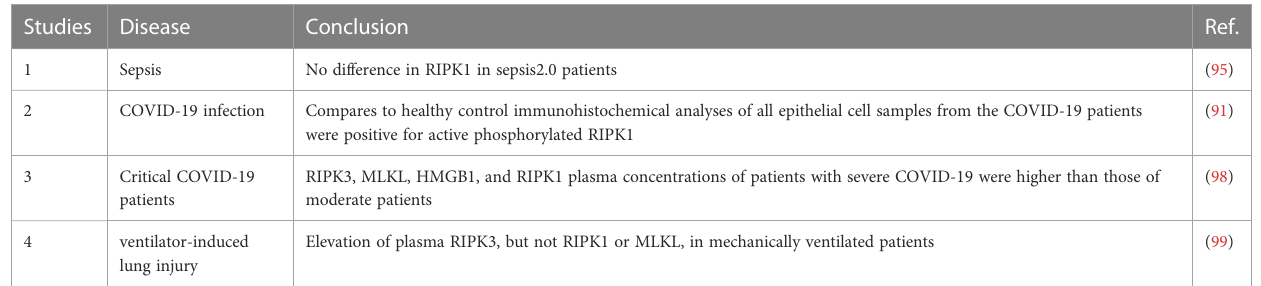
TABLE 4 clinical trial of RIPK1. Studies Disease